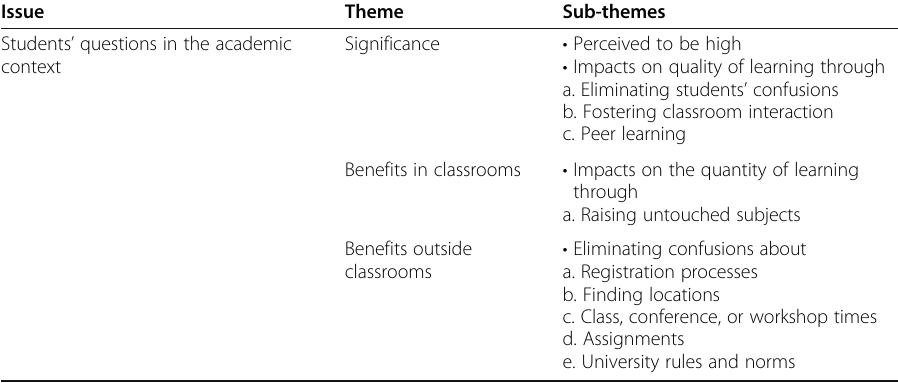
Table 3 NNGs ’ perceptions of non-native students ’ questioning in